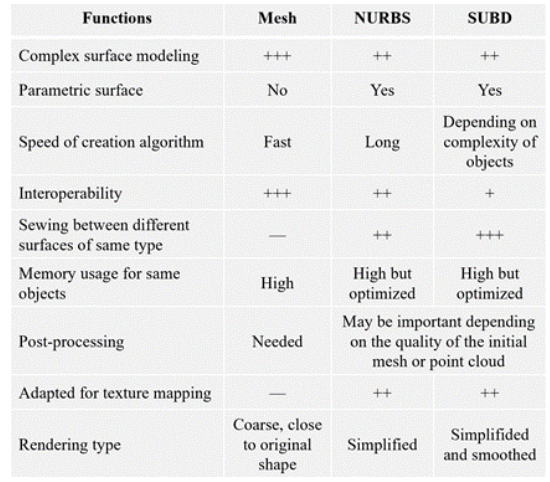
Table 1 . Comparison of the different types of